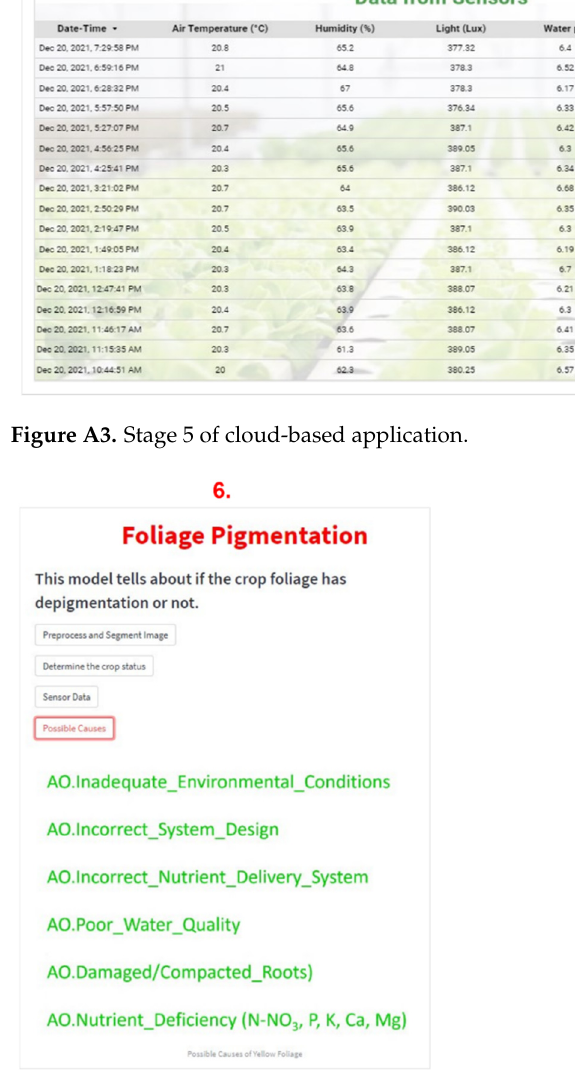
Figure A4. Stage 6 of cloud-based application.